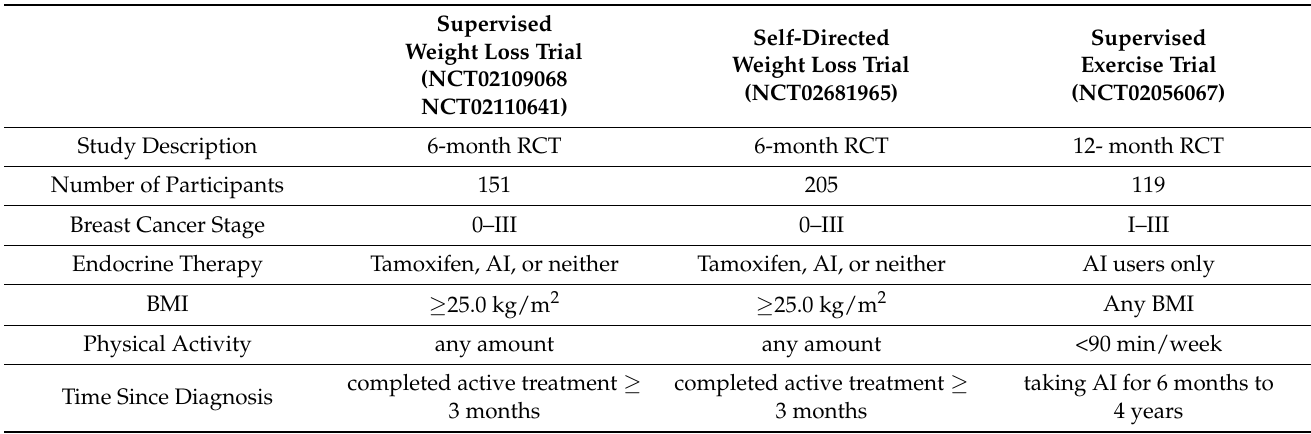
Table 1. Study eligibility